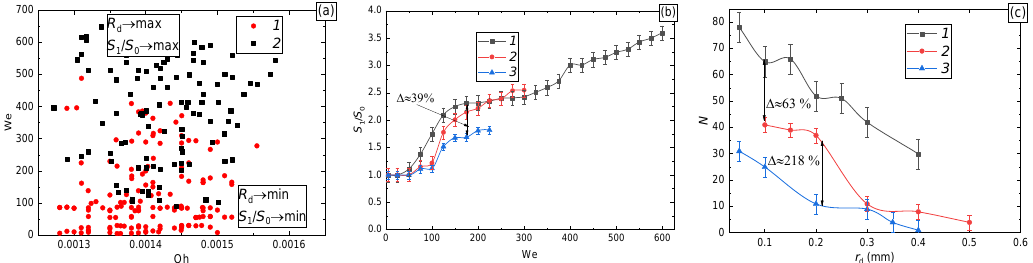
Figure 3. ( a ) Regime map of the drop impact on the surface as a function of We(Oh): 1 — deposition of the first drop and coalescence with all others; 2 — breakup; ( b ) S 1 / S 0 (We); ( c ) size distribution of the child droplets at We = 200 and with different sizes of the parent drop: 1 — R d = 2 – 2.7 mm; 2 — R d = 1 – 2 mm; 3 — R d = 0.5 – 1 mm.